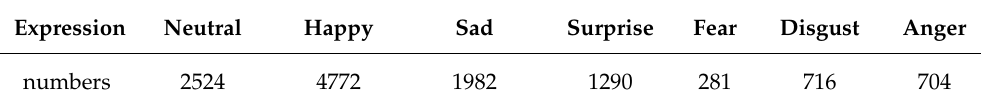
Table 1. We classify them according to the labels given by RAF-DB and show the data of each category. The number of happy and neutral expressions is 4772 and 2524, respectively, which is significantly higher than those of fear, disgust, and anger expressions.